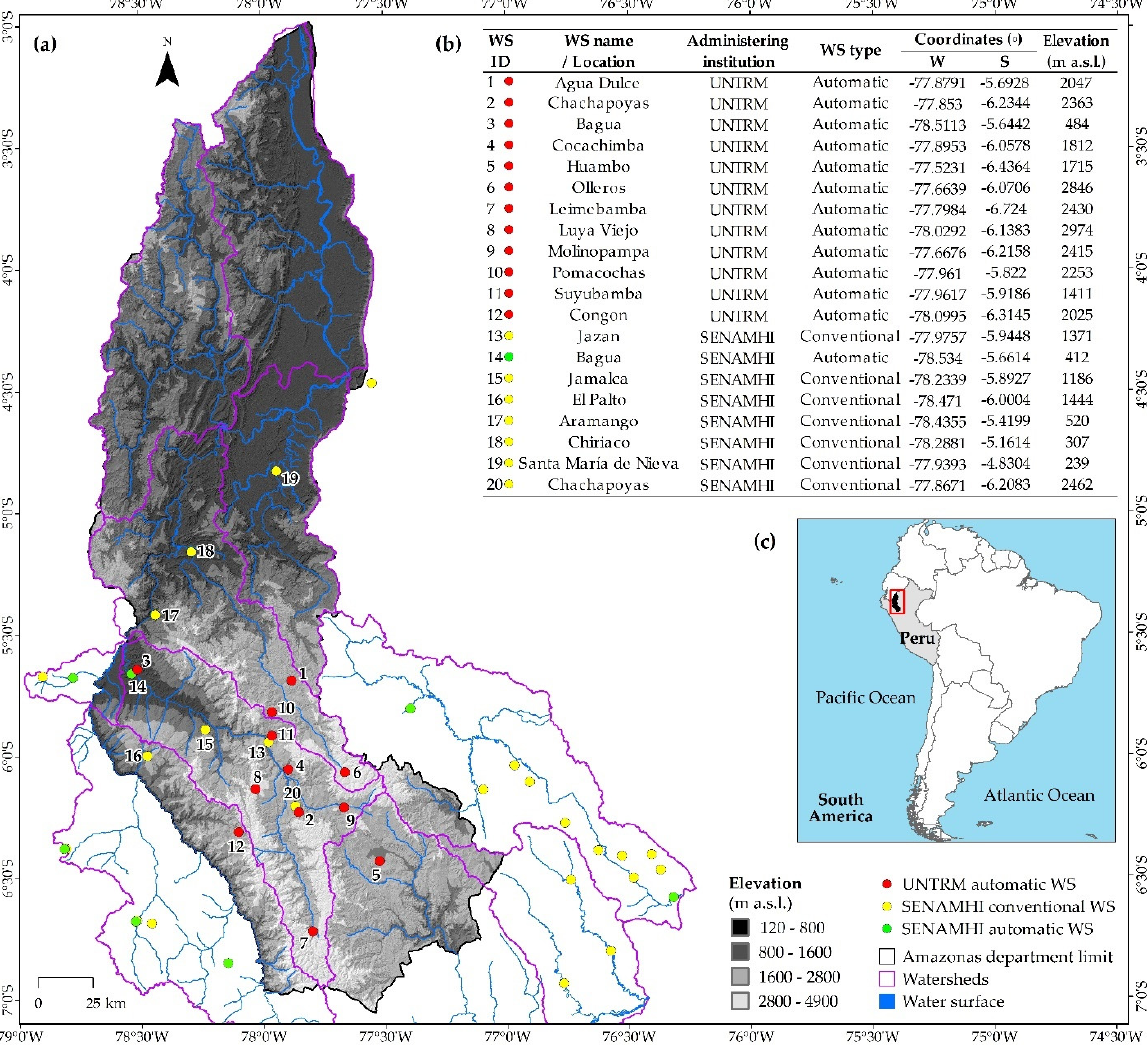
Figure 1. Current Weather Stations (WS) in the watersheds to which the Amazonas Department belongs ( a , b ), in NW Peru, South America ( c ).